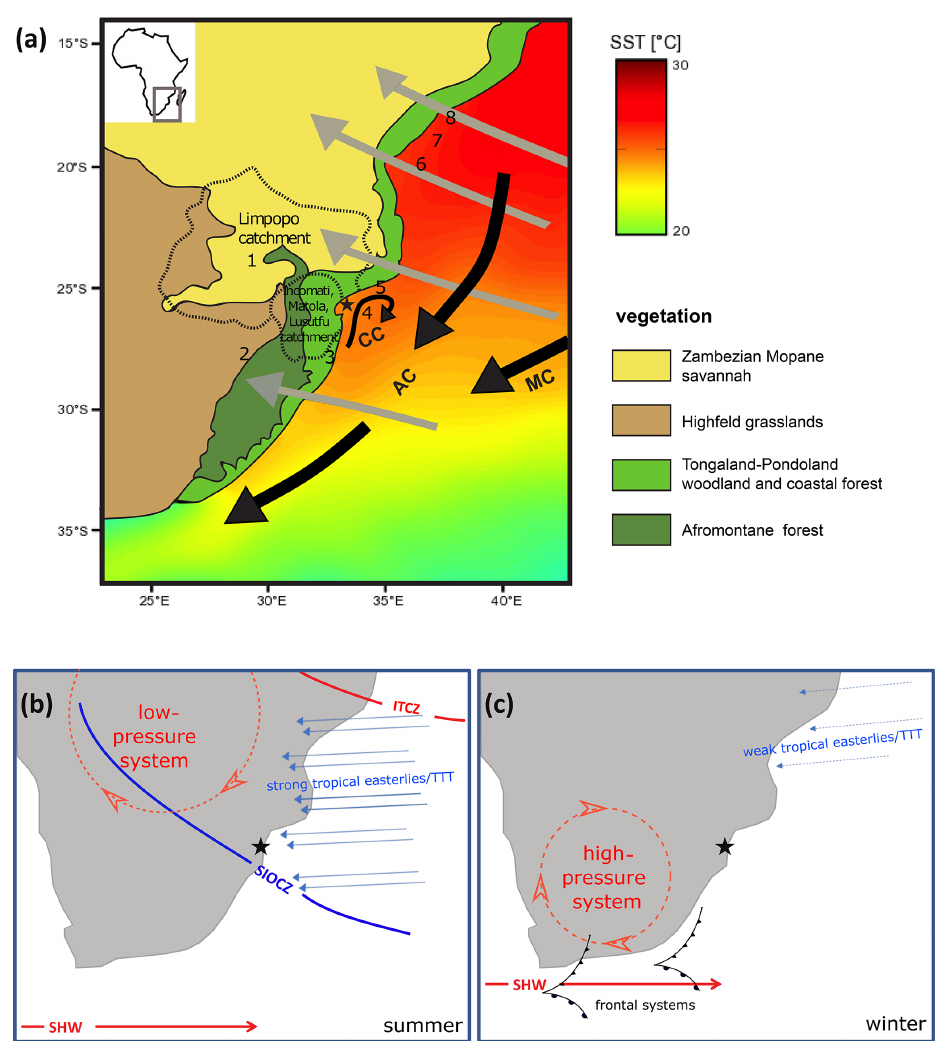
Figure 1. (a) Modern vegetation of southern Africa and the Incomati, Matola and Lusutfu catchments (after White, 1983) and annual SST over the Indian Ocean (Locarnini et al., 2013). Gray arrows represent the main easterly transport of moisture from the warm Indian Ocean. The Mozambique Current (MC), Agulhas Current (AC) and countercurrent (cc) forming a coastal eddy are shown in black. Sites mentioned in the discussion are numbered as (1) Wonderkrater (Truc et al., 2013), (2) Braamhoek (Norström et al., 2009), (3) Mfabeni (Miller et al., 2019), (4) MD96-2048 (Dupont et al., 2011; Caley et al., 2011, 2018), (5) GeoB20610-1 (Miller et al., 2020), (6) GIK16160-3 (Wang et al., 2013), (7) MD79-257 (Bard et al., 1997; Sonzogni et al., 1998; Levi et al., 2007) and (8) GeoB9307-3 (Schefuß et al., 2011). (b) Map of southern Africa in austral summer showing the schematic position of the low-pressure system, the ITCZ (Intertropical Convergence Zone), the SIOCZ (South Indian Ocean Convergence Zone) and related rain-bearing TTTs (tropical temperate troughs). (c) Map of southern Africa in austral winter showing the schematic position of the high-pressure system, the weaker TTTs and the frontal systems associated with the northward-shifted SHWs (southern hemispheric